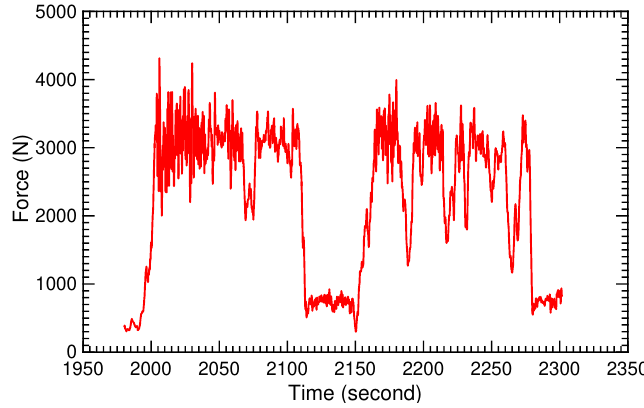
Figure 33. Recorded tether force for two pumping